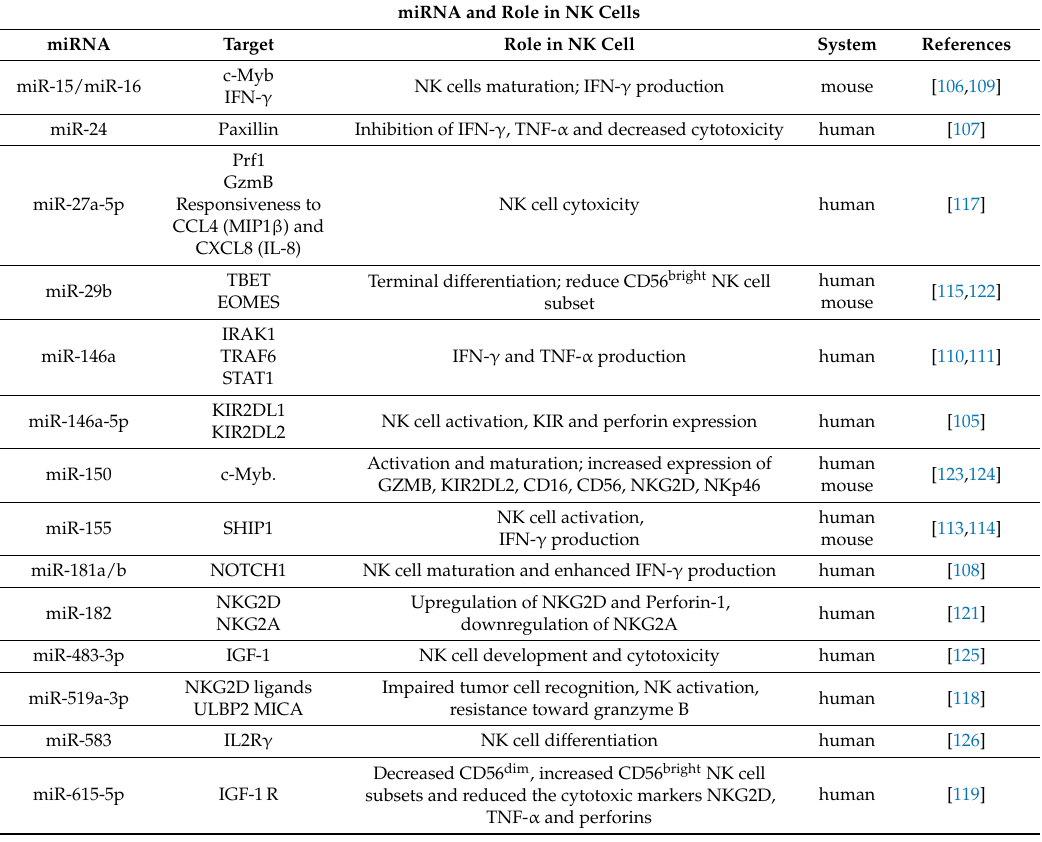
Table 1. Effects of microRNAs (miRNAs) on NK cell anti-tumor